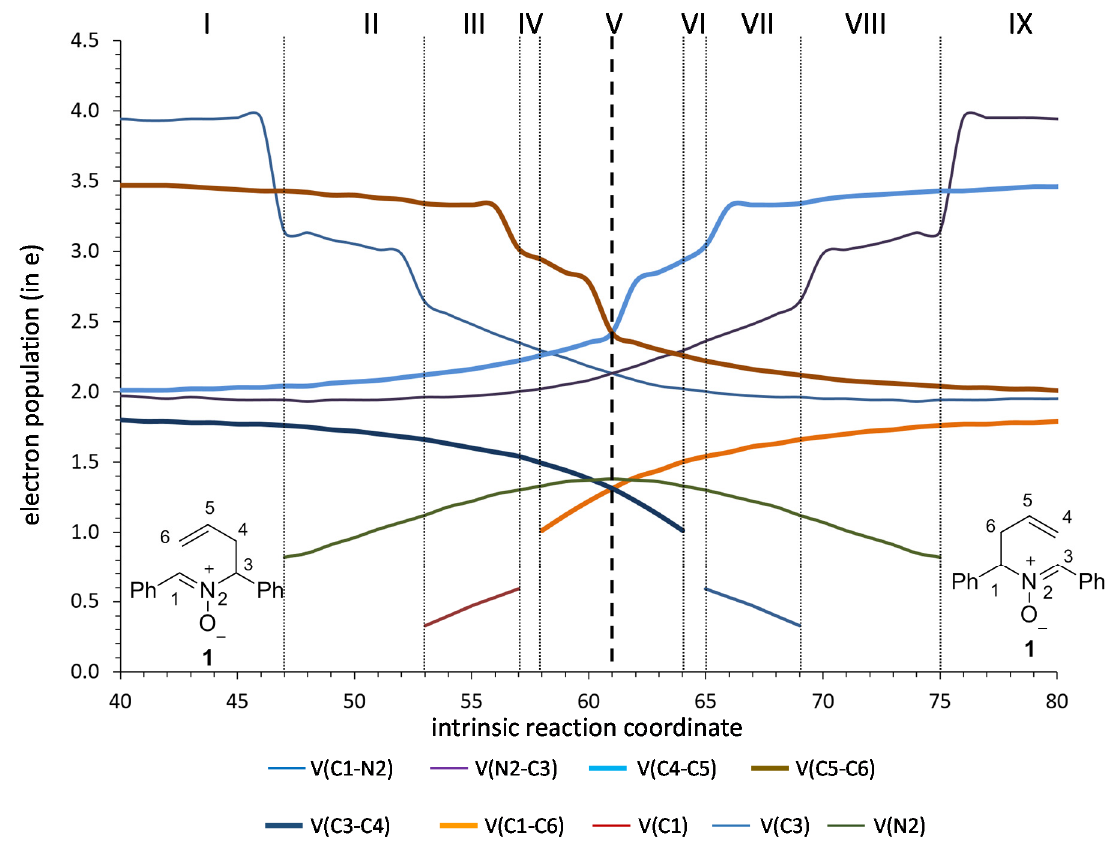
Figure 3. Graphical representation of the basin-population changes along the 2-aza-Cope rearrangement of nitrone 1 . Only atoms/bonds that change their electron density and a zoom of 40 points before and after the transition structure is shown in all Figures. For the complete representations, see supplementary information.